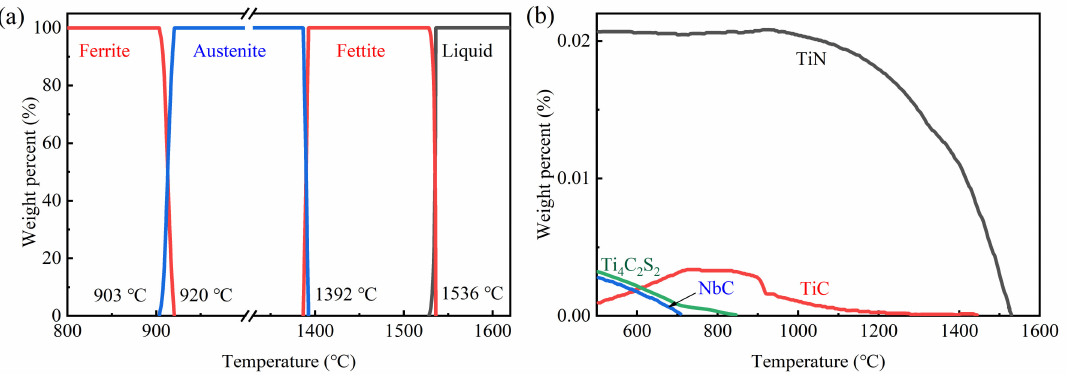
Figure 4. Thermodynamics calculation: ( a ) phase evolution and ( b ) precipitation as a function of